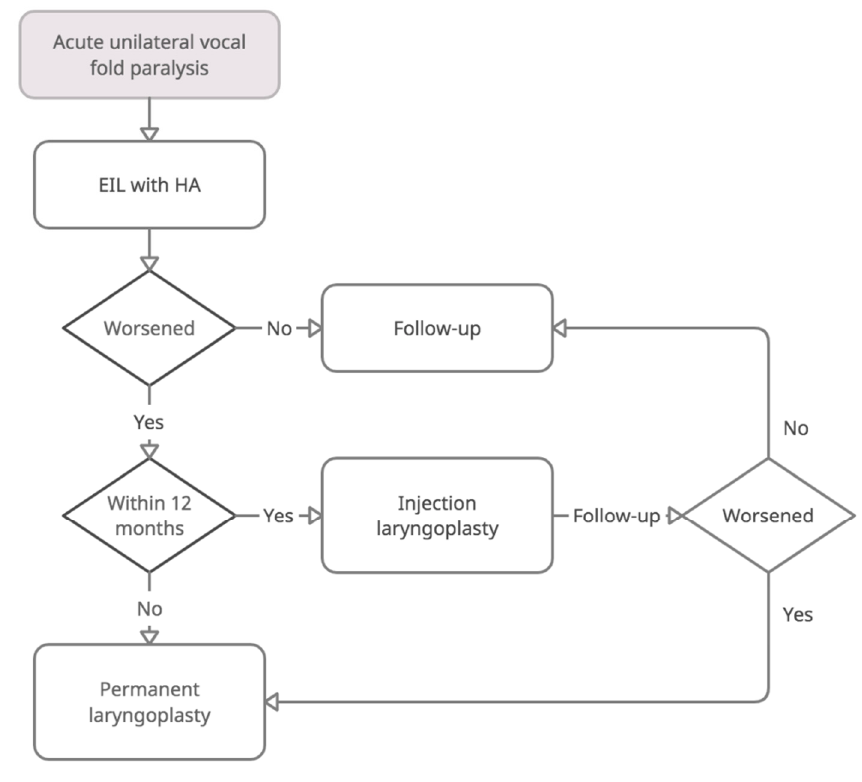
Figure 4. Recommendation for treatment guidelines for acute unilateral vocal fold paralysis. EIL = early injection laryngoplasty; HA = hyaluronic acid.